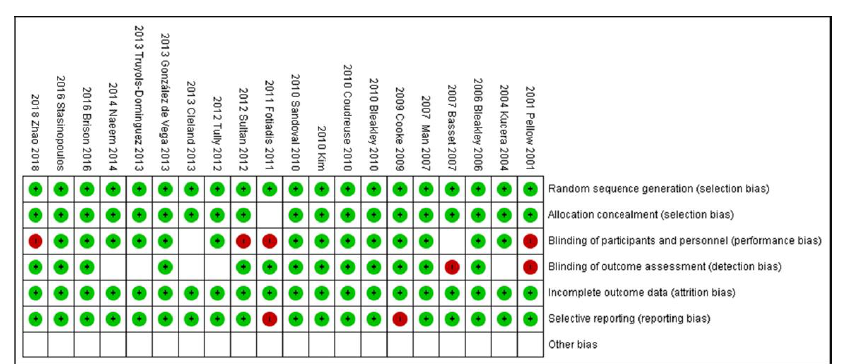
Figure 3. Risk of bias summary.